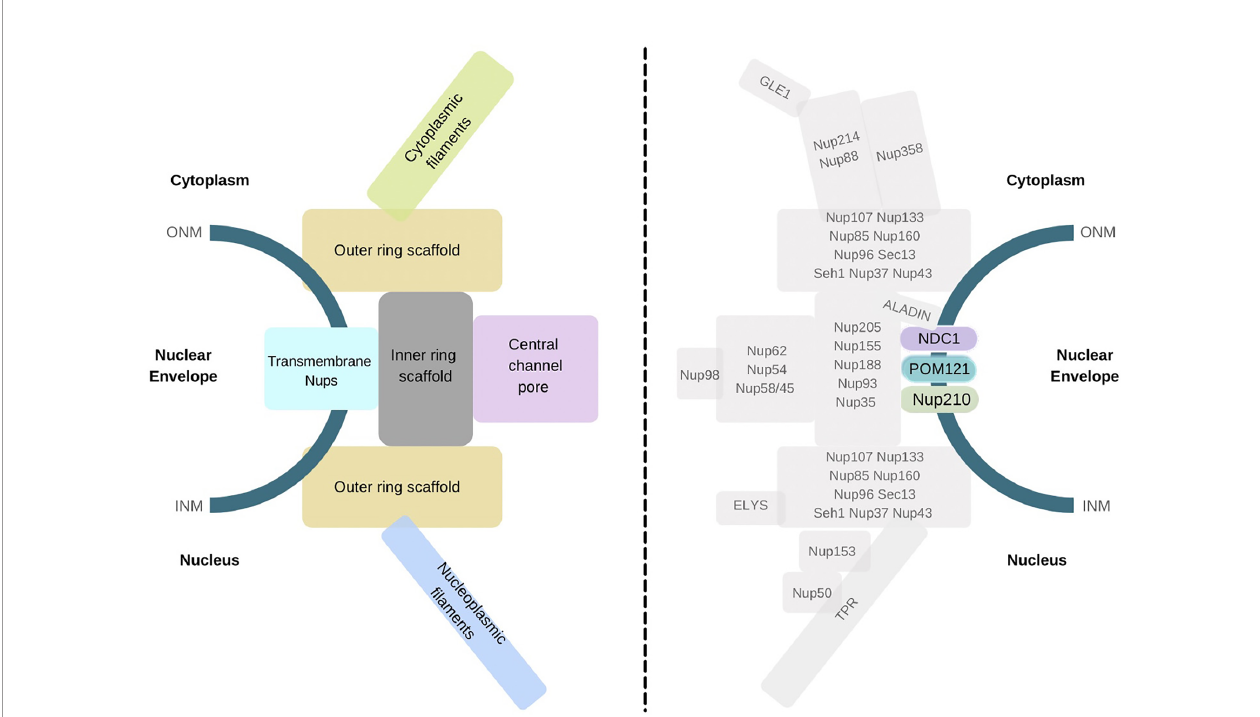
FIGURE 1 | Schematic representation of NPC sub-complexes and constituent nucleoporins. A snapshot representation of nucleo-cytoplasmic face distribution of NPC sub-complexes across the nuclear membrane (left) and localization of individual Nups at the NPC (right). The distinct transmembrane Nups, POM121, NDC1, and Nup210 are highlighted and color-coded